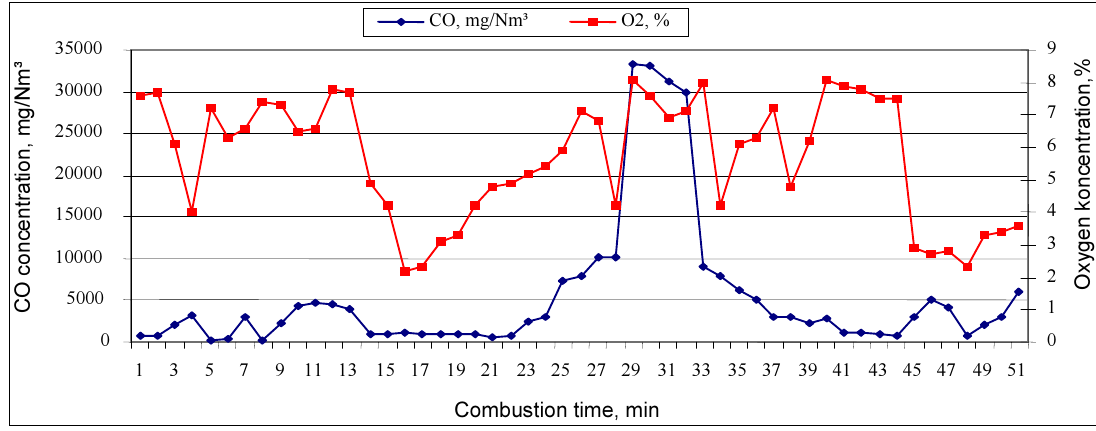
Fig. 2. Change of composition of smoke burning fire-wood